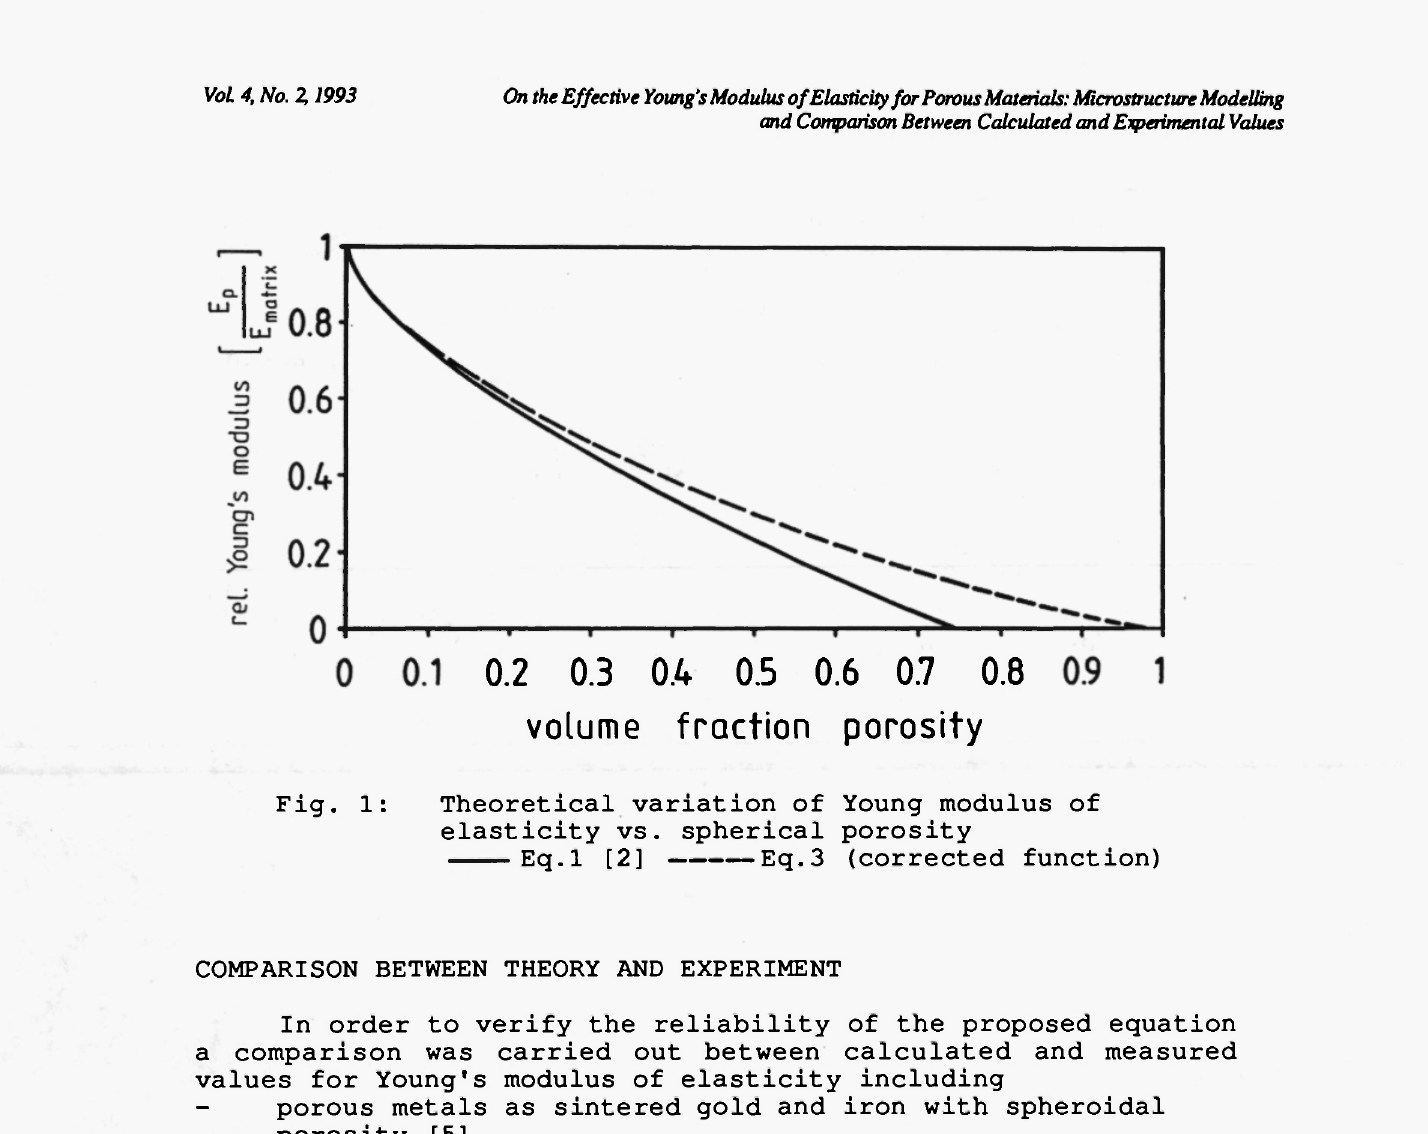
COMPARISON BETWEEN THEORY AND